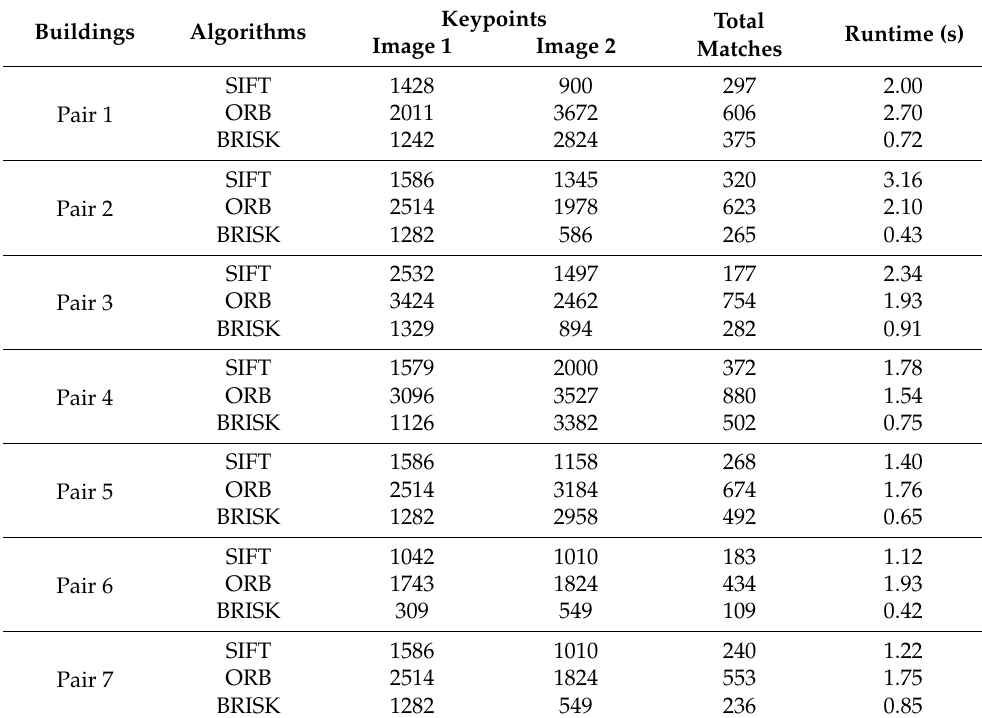
Table 4. Quantitative comparison and computational cost by algorithms for pairs of tobacco industry with other buildings. Buildings Algorithms